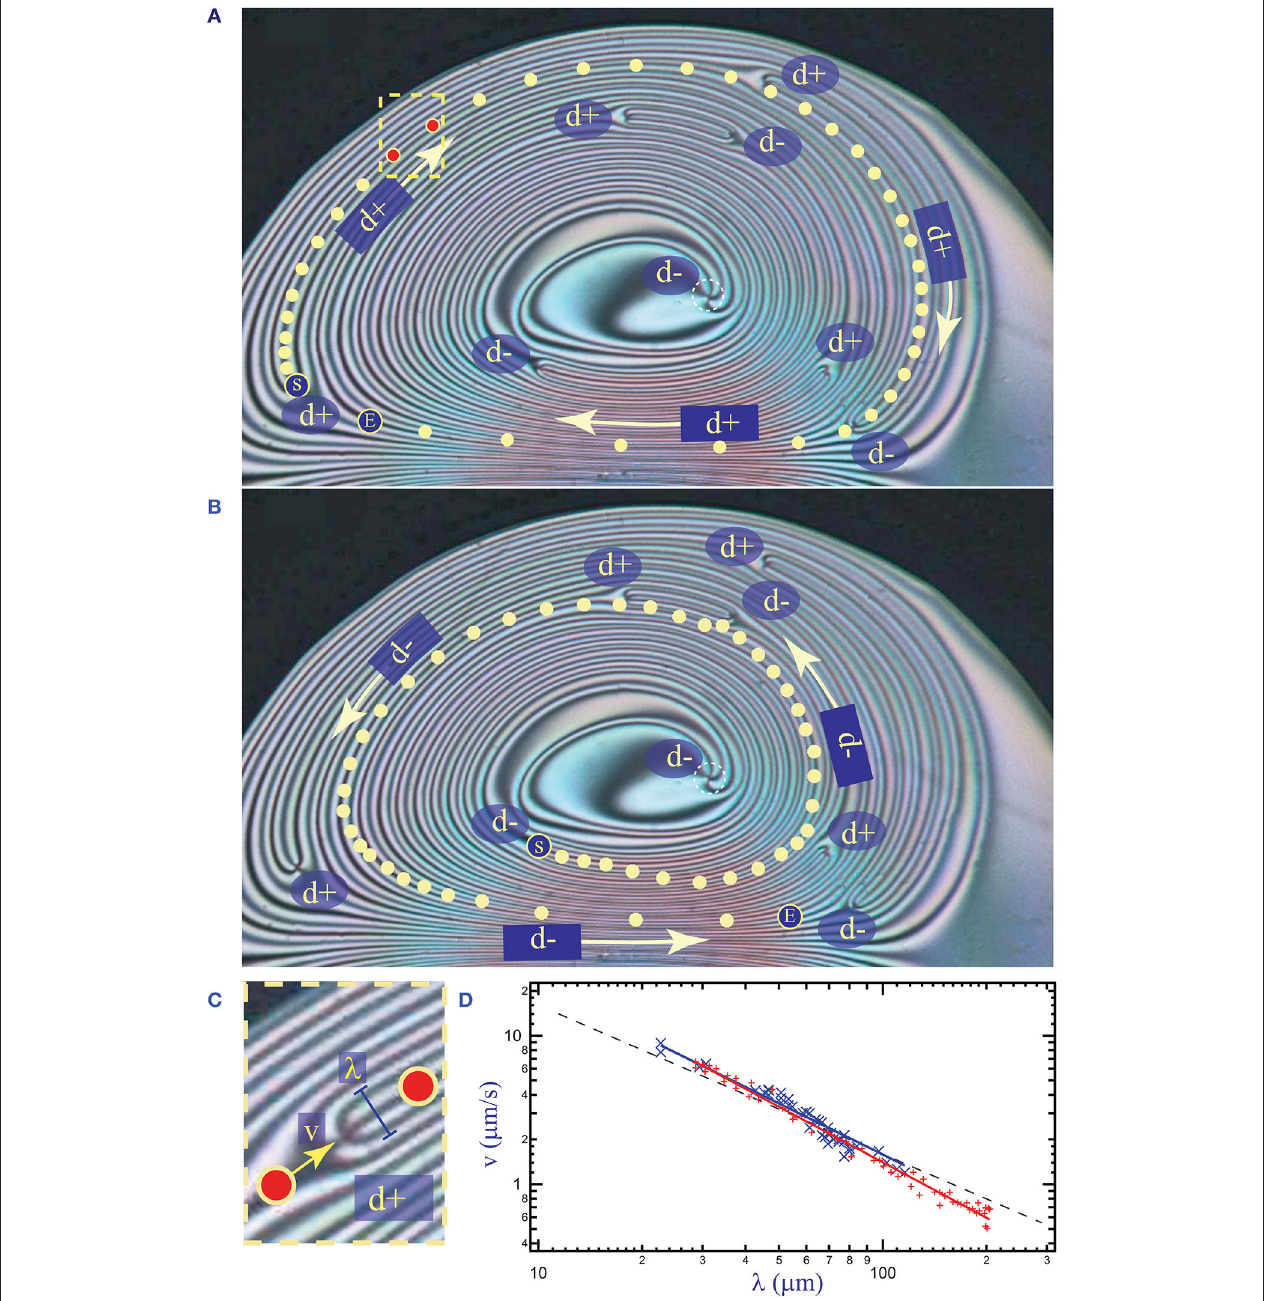
FIGURE 7 | Trajectories of two dowsons, d + and d − , in the DDC. Circular markers indicate successive positions of dowsons at time intervals of 30 s. Trajectories start from larger markers labeled “S” and end at markers labeled “E.” (A) The dowson d + circulates in the clockwise direction of the phase winding. (B) The dowson d − circulates in the opposite, anticlockwise direction. Its trajectory starts in the vicinity of the center of the target pattern and ends at the periphery. Clearly such a trajectory is not isophasic. (C) Segment of the trajectory inside the dashed frame displayed in (A) . (D) Blue crosses: velocity of the dowson d + from (A) plotted vs. the width λ of the 2 π wall pulling on it. Continuous blue line: the best fit to the power law with the exponent α = − 1.14. Red crosses and the red line: reminder of the data from Figure 5 . The dashed black line corresponds to α = −